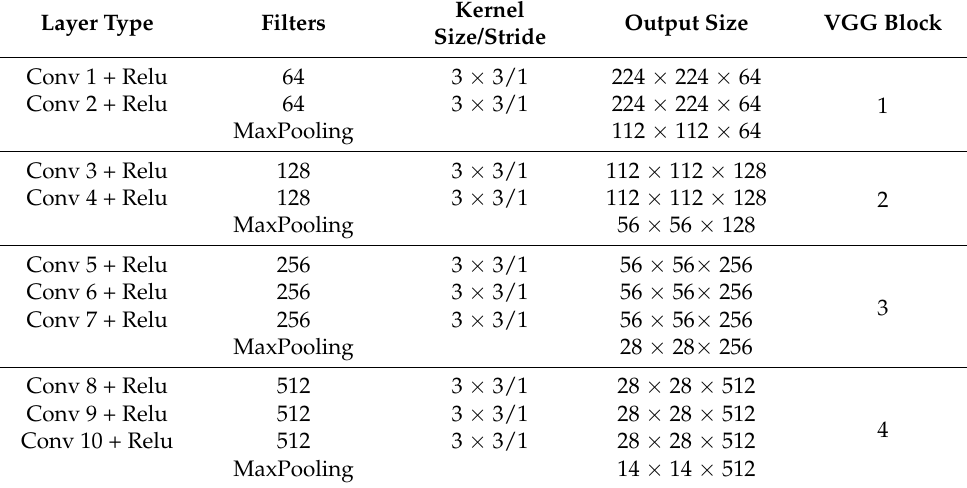
Table 1. Two convolutional layers are used in each of the first two VGG blocks, and three convolutional layers are used in each of the last three VGG blocks. VGG-16 consists of 3 fully connected layers in addition to the 13 convolutional layers. Table 1. Architecture of VGG-16